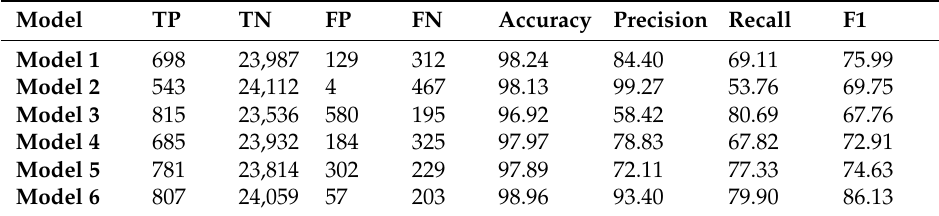
Figure 10. Models’ test results on the El Centro earthquake at a scale of 100% (left) and 50% (right); the results are ordered from top to bottom for each subfigure’s sensor, namely ADXL355, LIS3DHH, MMA8452, and MPU9250. Table 5. Performance evaluation of the ANN models on the original test data using a 0.9 threshold value.